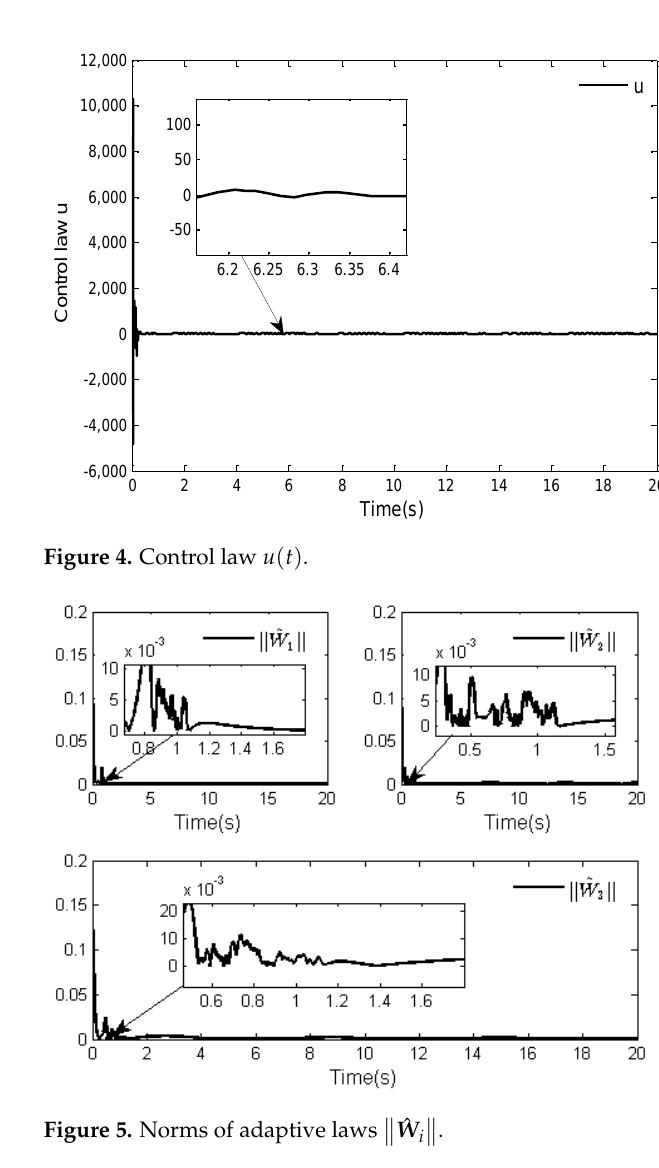
Figure 3. System states